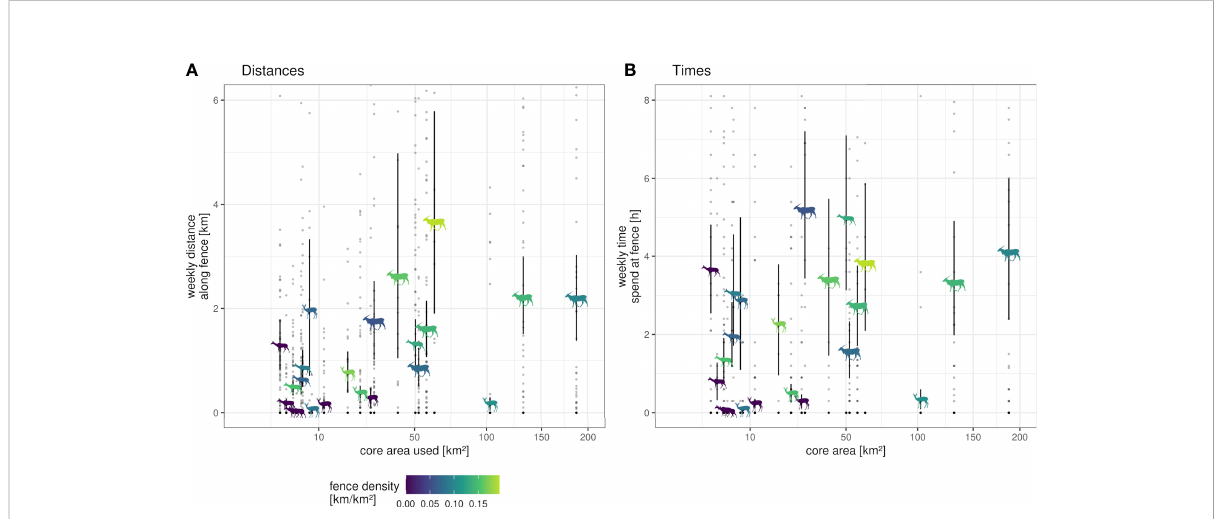
FIGURE 6 Weekly distances (A) and times (B) individuals spent at fence lines projected on the core area they used from end of dry season 2020 to end of dry season 2021. Shown are mean values (icon position) on the y -axis separated by individual and species with lower (0.025) and upper (0.975) con fi dence intervals from bootstrapping (1,000 iterations) shown by black, vertical lines. Fence density within each individuals ’ core area indicated by color (see legend). Individuals are ordered by their used core area ( x -axis, area based on 50% of kernel density estimates with ad hoc method for smoothing parameter calculation). Single points depict values of single weeks of observation. Note: the y -axis is limited to upper CI; data are not. The x -axis is square root-transformed; data are not.